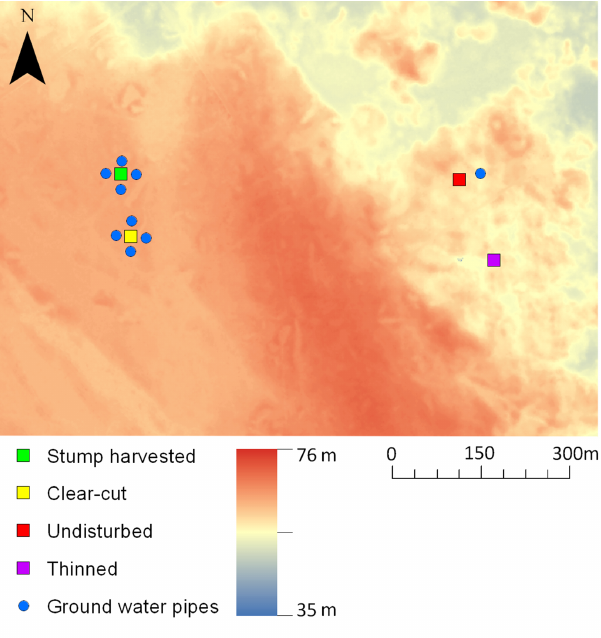
Figure 1. Schematic picture of the different plots and some of the groundwater pipes. Three more pipes are located within the clear- cut and at the stump harvested plots, but are covered by the plot symbol. The background consists of a digital elevation model show- ing the height above sea level for each square metre (Digital eleva- tion model (DEM) data kindly provided by N. Kljun et